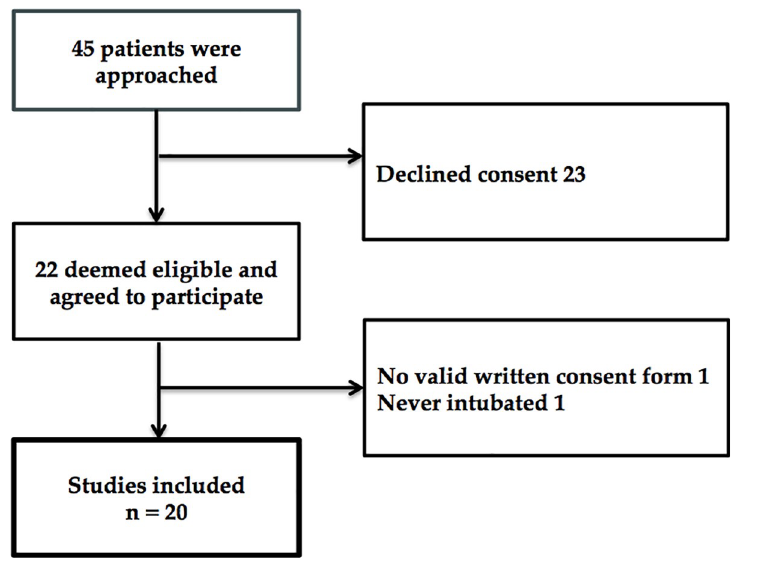
Fig 1. Recruitment flow diagram.